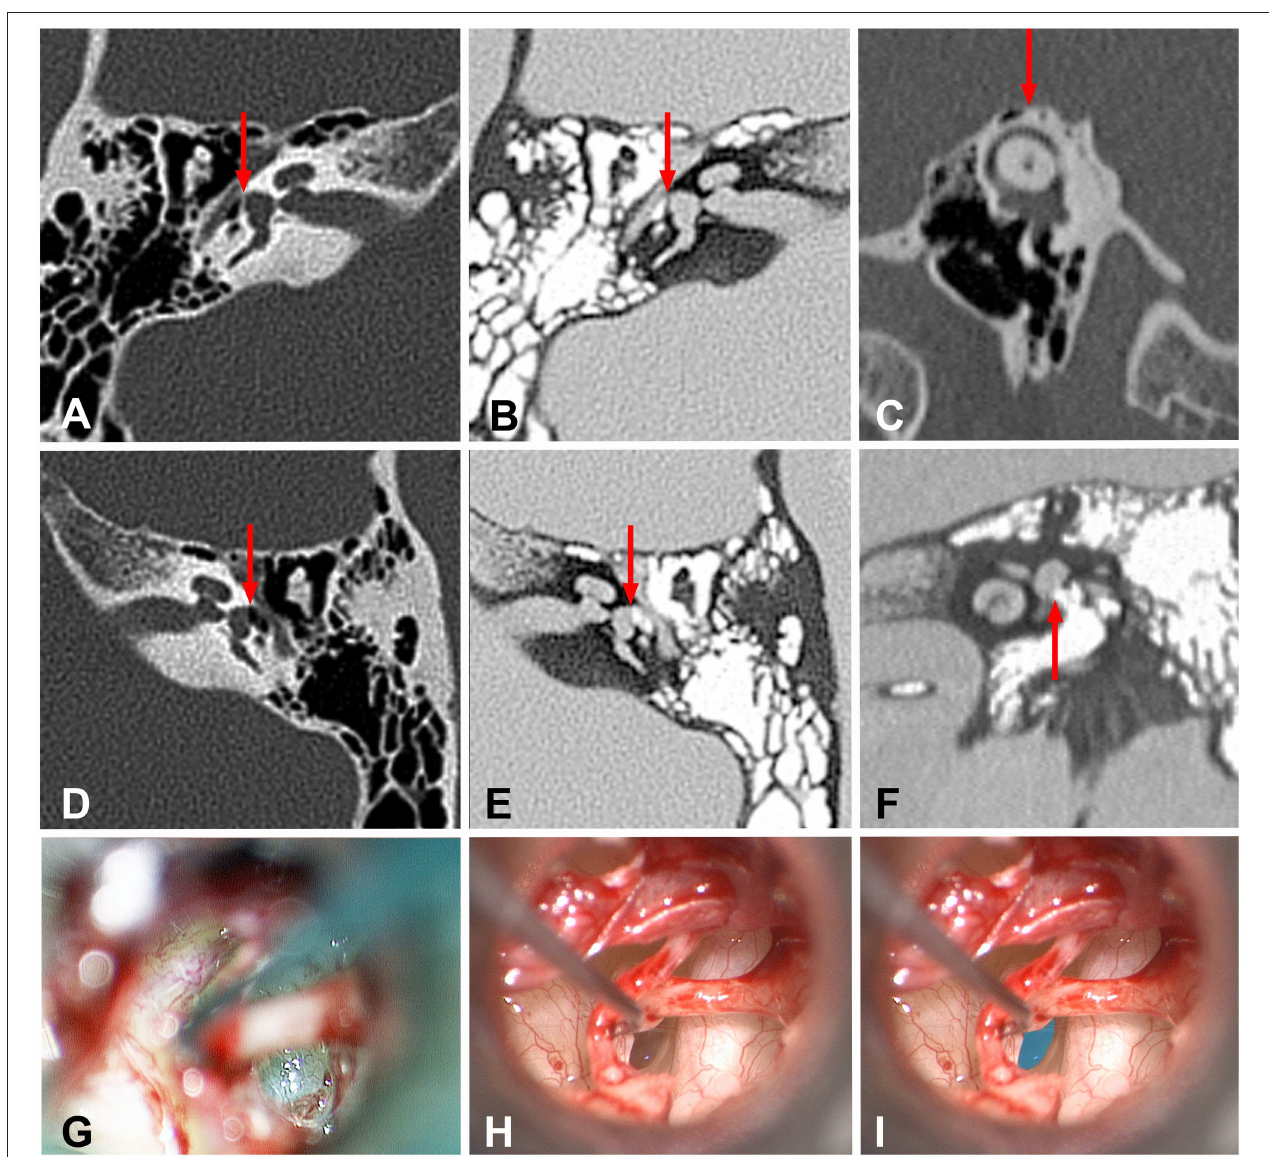
FIGURE 1 | High resolution temporal bone CT images of the normal and abnormal stapes footplate as well as intraoperative images of the hypermobile stapes footplate. (A) Traditional axial image of the right temporal bone with bone windows shows the cochlea, internal auditory canal, vestibule, middle ear. Red arrow shows the normal stapes footplate (white line) providing the interface between the vestibule and middle ear. (B) Same image as seen in this figure (A) using the “invert” function. Note the ease in comparing the air in the middle ear (white) to the fluid-filled vestibule (gray). Red arrow shows the position of the normal stapes footplate (black line) providing the interface between the vestibule and middle ear. (C) Traditional Poschl image of the left temporal bone with bone windows shows that in this case of left third window syndrome, there is no superior semicircular canal dehiscence (red arrow). (D) Traditional axial image of the left temporal bone with bone windows shows the cochlea, internal auditory canal, vestibule, middle ear. Red arrow shows the position of the membranous stapes footplate providing the interface between the vestibule and middle ear. Note the absence of the white line seen in this figure (A) . (E) Same image as seen in this figure (D) using the “invert” function. Note the ease in comparing the air in the middle ear (white) to the fluid-filled vestibule (gray). Red arrow shows the position of the membranous stapes footplate providing the interface between the vestibule and middle ear. Note the absence of the black line representing the normal stapes footplate seen in this figure (B) . (F) Inverted coronal image of the left temporal bone with bone windows shows the cochlea, vestibule and middle ear. Red arrow shows the position of the membranous stapes footplate providing the interface between the vestibule and middle ear. Note the absence of the black line representing the normal stapes footplate. (G) Intraoperative appearance of a normal stapes footplate. (H) Intraoperative appearance of a membranous stapes footplate. Note the translucent appearance of the entire stapes footplate. The bone-covered tympanic segment of the facial nerve can be seen to the right of the stapes footplate. (I) The stapes footplate is shaded in blue to illustrate the position of the membranous stapes footplate image seen in this figure (H) .